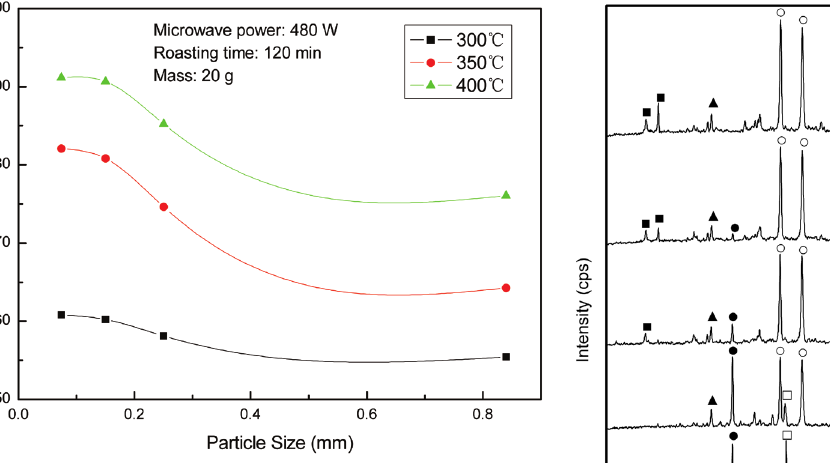
Fig. 5: Effect of particle size on dechlorination efficiency of Cu residue